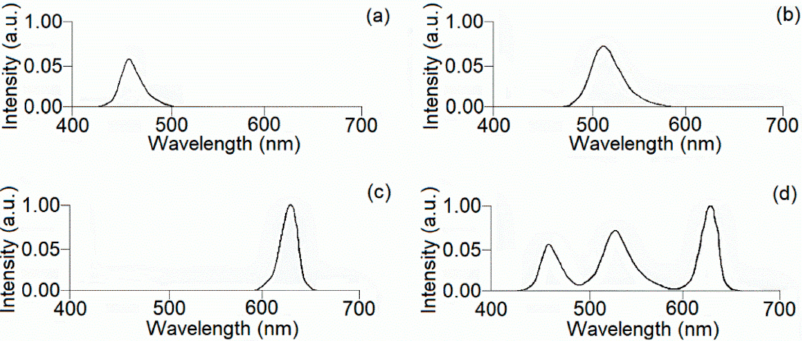
Figure 7. The spectral power distributions of the RGB LED lamp used in this study: ( a ) blue; ( b ) green; ( c ) red; and ( d )